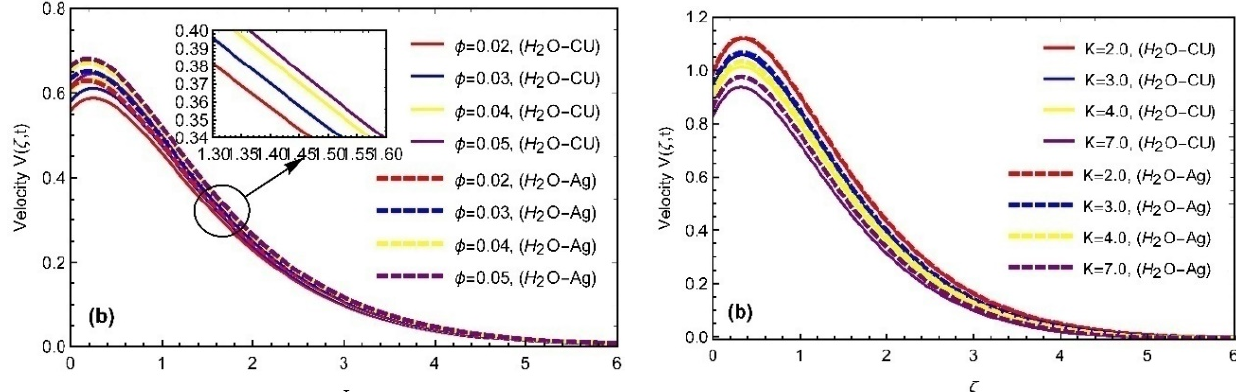
Figure 9. Momentum fields for ( a ) ϕ and ( b ) K with α = β = γ = 0.6, Pr = 6.0, Sc = 1.6, Gr = 6.2, Gm = 4.3, h = 0.5, K = 3.2, M = 1.2, θ 1 = θ 2 = π